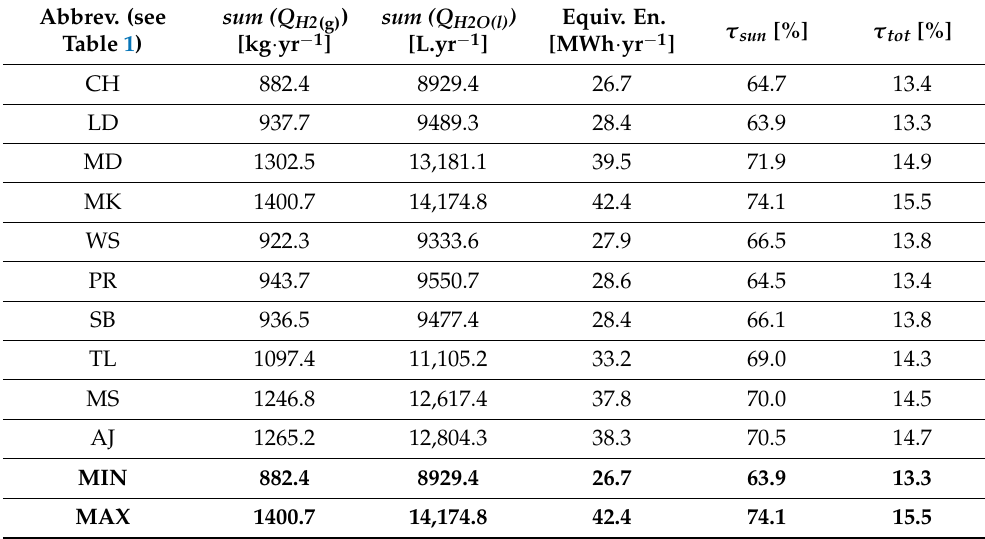
Table 4. Simulation results for yearly H 2(g) local capacities [kg · yr − 1 ], equivalent energy [MWh · yr − 1 ] and others physical parameters for year 2005 (historical